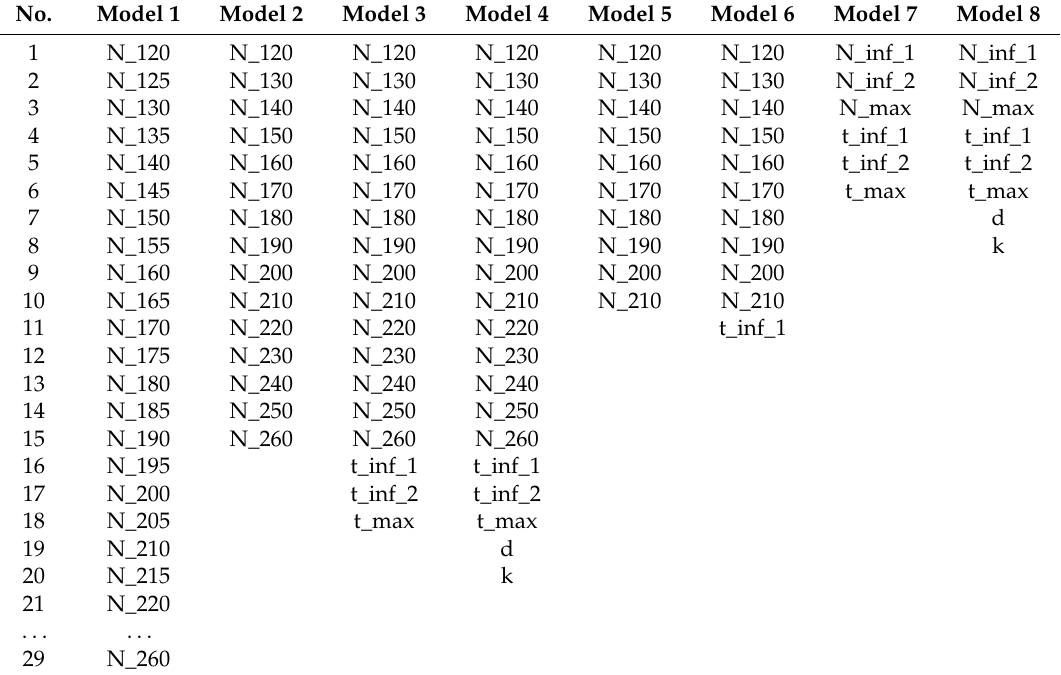
Table 3. Inputs for the crop estimation